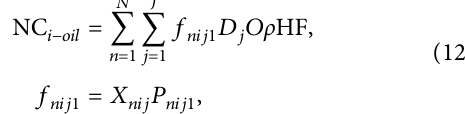
spectively; additionally, the red lines represent online shopping activities, and the black lines represent offline shopping